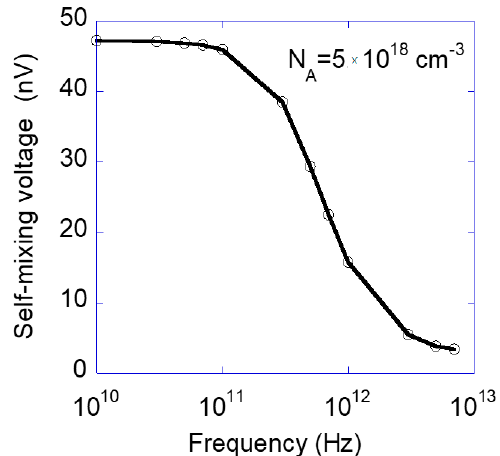
Figure 8. Frequencydependenceofpotentialgeneratedatsilicon–oxideinterface, y = 0, Figure 8. Frequency dependence of potential generated at silicon–oxide interface, y = 0, by self-mixing effect.